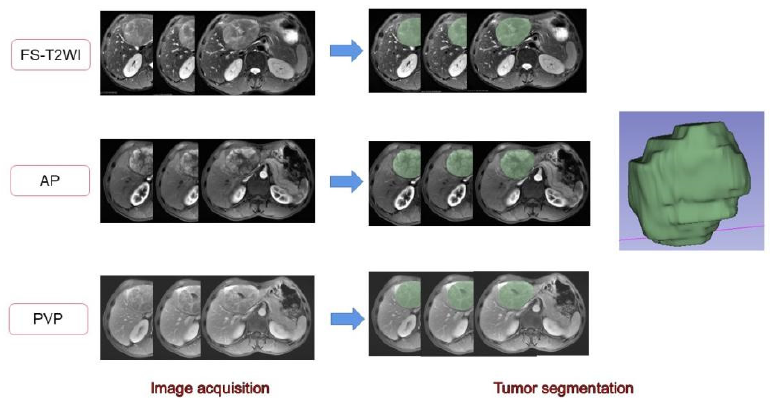
Table 2. Clinical characteristics of patients in the high and low PD-L2 expression groups. Clinical Variables Figure 2. Delineation of the target area and generation of the full VOI. The 2D region of interests (ROIs) were manually delineated on FS-T2WI and dynamic contrast-enhanced MRI. Three-dimensional views were automatically generated for all ROIs.